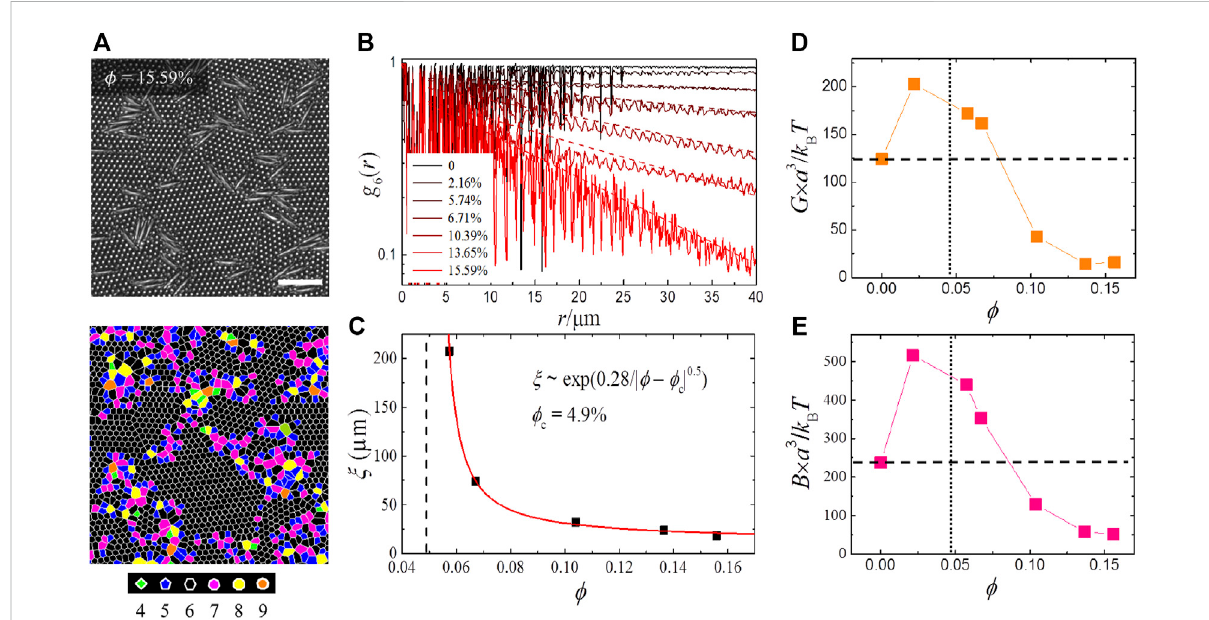
FIGURE 2 (A) Bright- fi eldmicrographsofmonolayersofsphereswithellipsoidimpuritiesandthecorrespondingVoronoidiagram. Thescalebaris20 μ m. (B) g 6 ( r ) vs. ϕ . The dashed curves are fi ts of g 6 ( r ) to e − r / ξ . (C) ξ vs. ϕ . The red line is a fi tting curve as indicated. (D , E) Shear and Bulk moduli vs. ϕ . The vertical dotted lines label the critical impurity density. (A – E) Reprinted from [19] with permission of American Physical